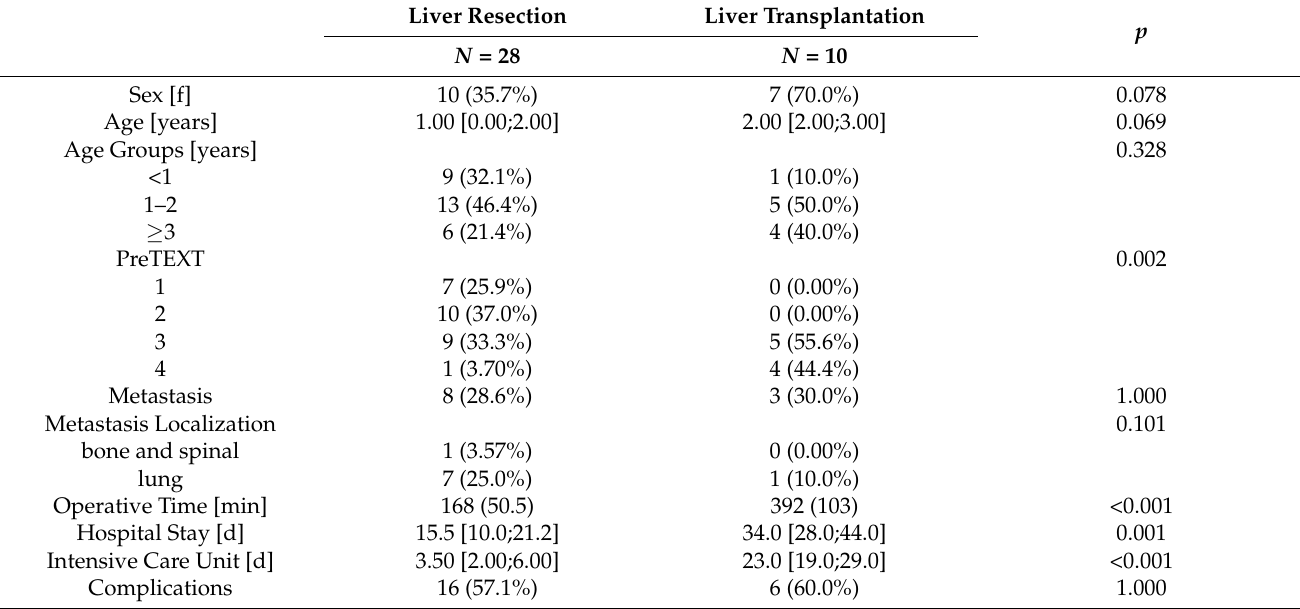
Table 1. Liver Transplantation and Liver Resection compared. Liver